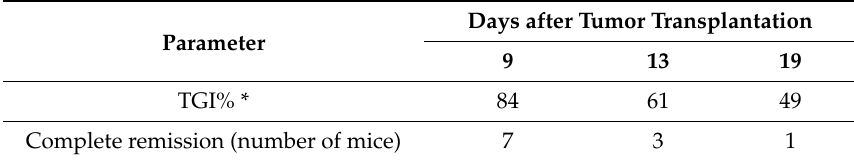
Table 3. Antitumor effect on s.c. Lewis lung carcinoma in mice (n = 13) after the oral anthrafuran treatment for 5 days.